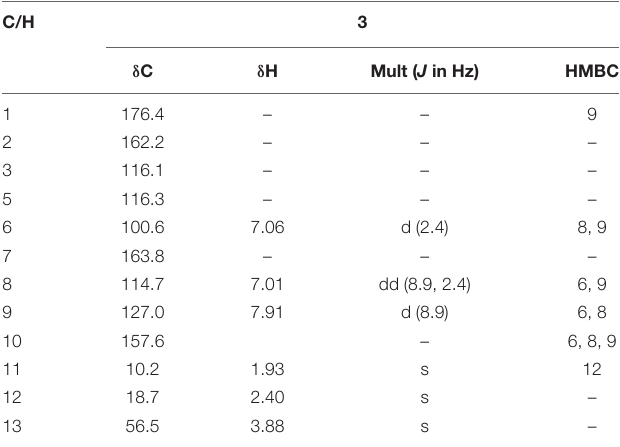
TABLE 3 | 1 H (600 MHz) and 13 C (150 MHz) NMR data for 3 in DMSO- d 6